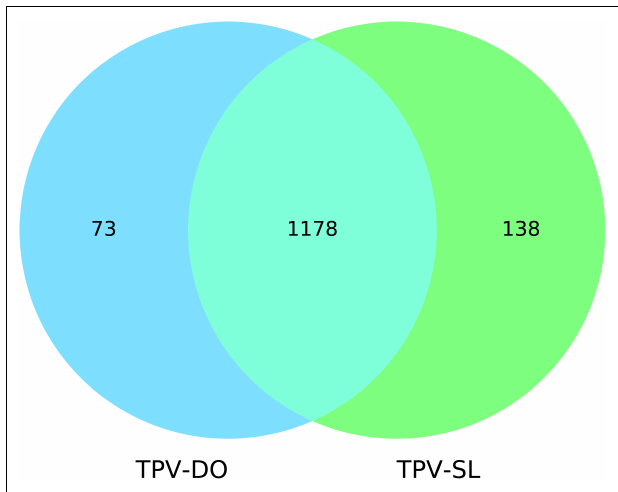
FIGURE 2 | Venn diagram of genes shared and not shared by the two